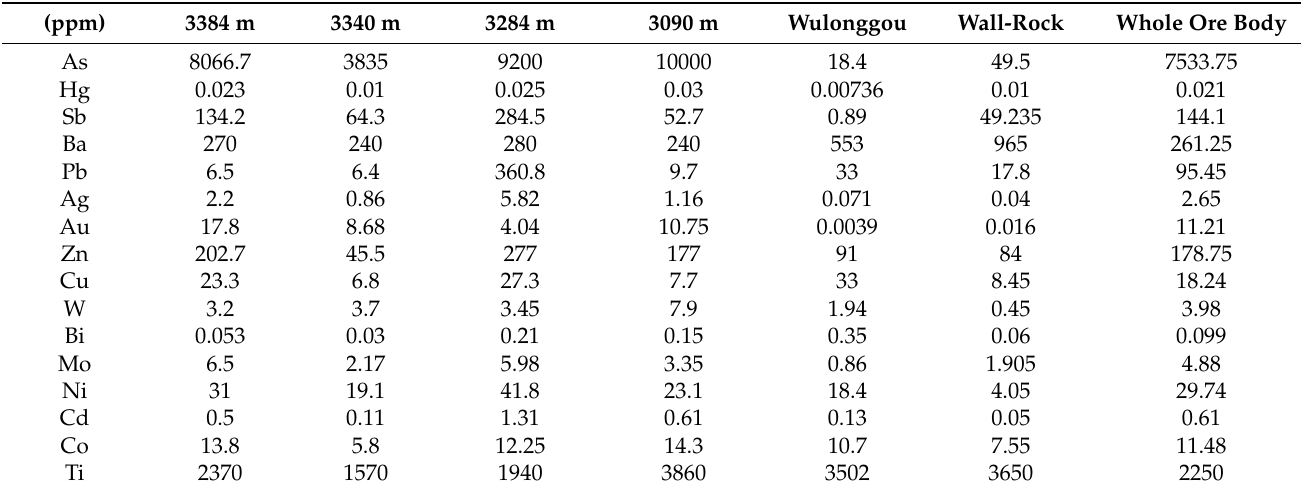
Table 3. Elemental concentrations of each elevation and